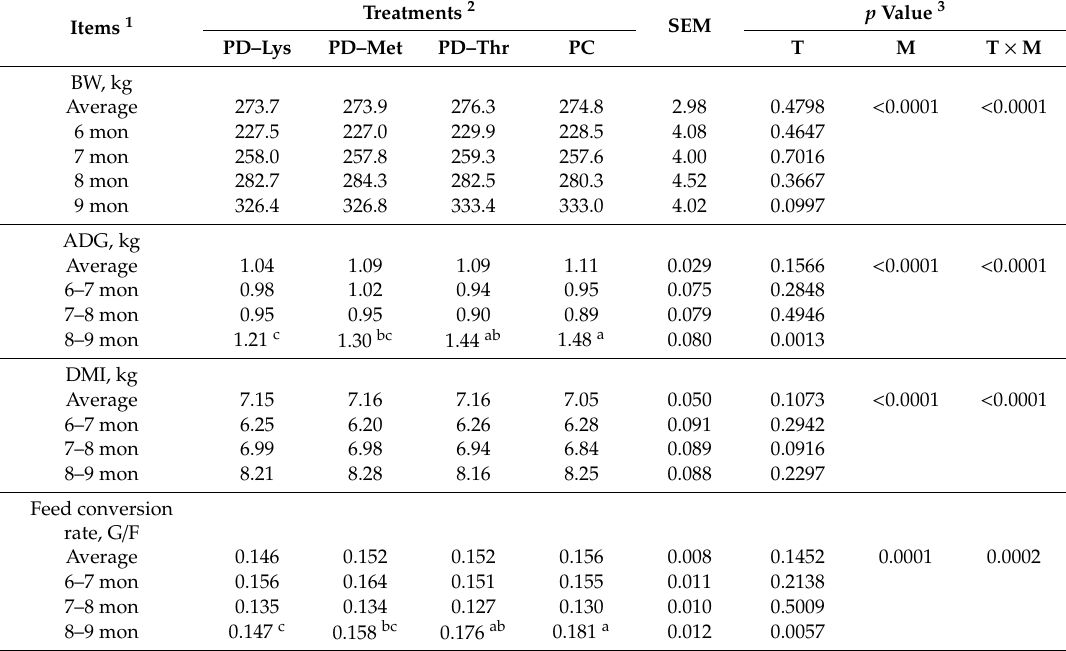
Table 3. E ff ects of deleting Lysine (Lys), Methionine (Met), and Threonine (Thr) levels in corn–soybean based TMR on the growth performance of heifers aged seven to nine months old (n = 72).